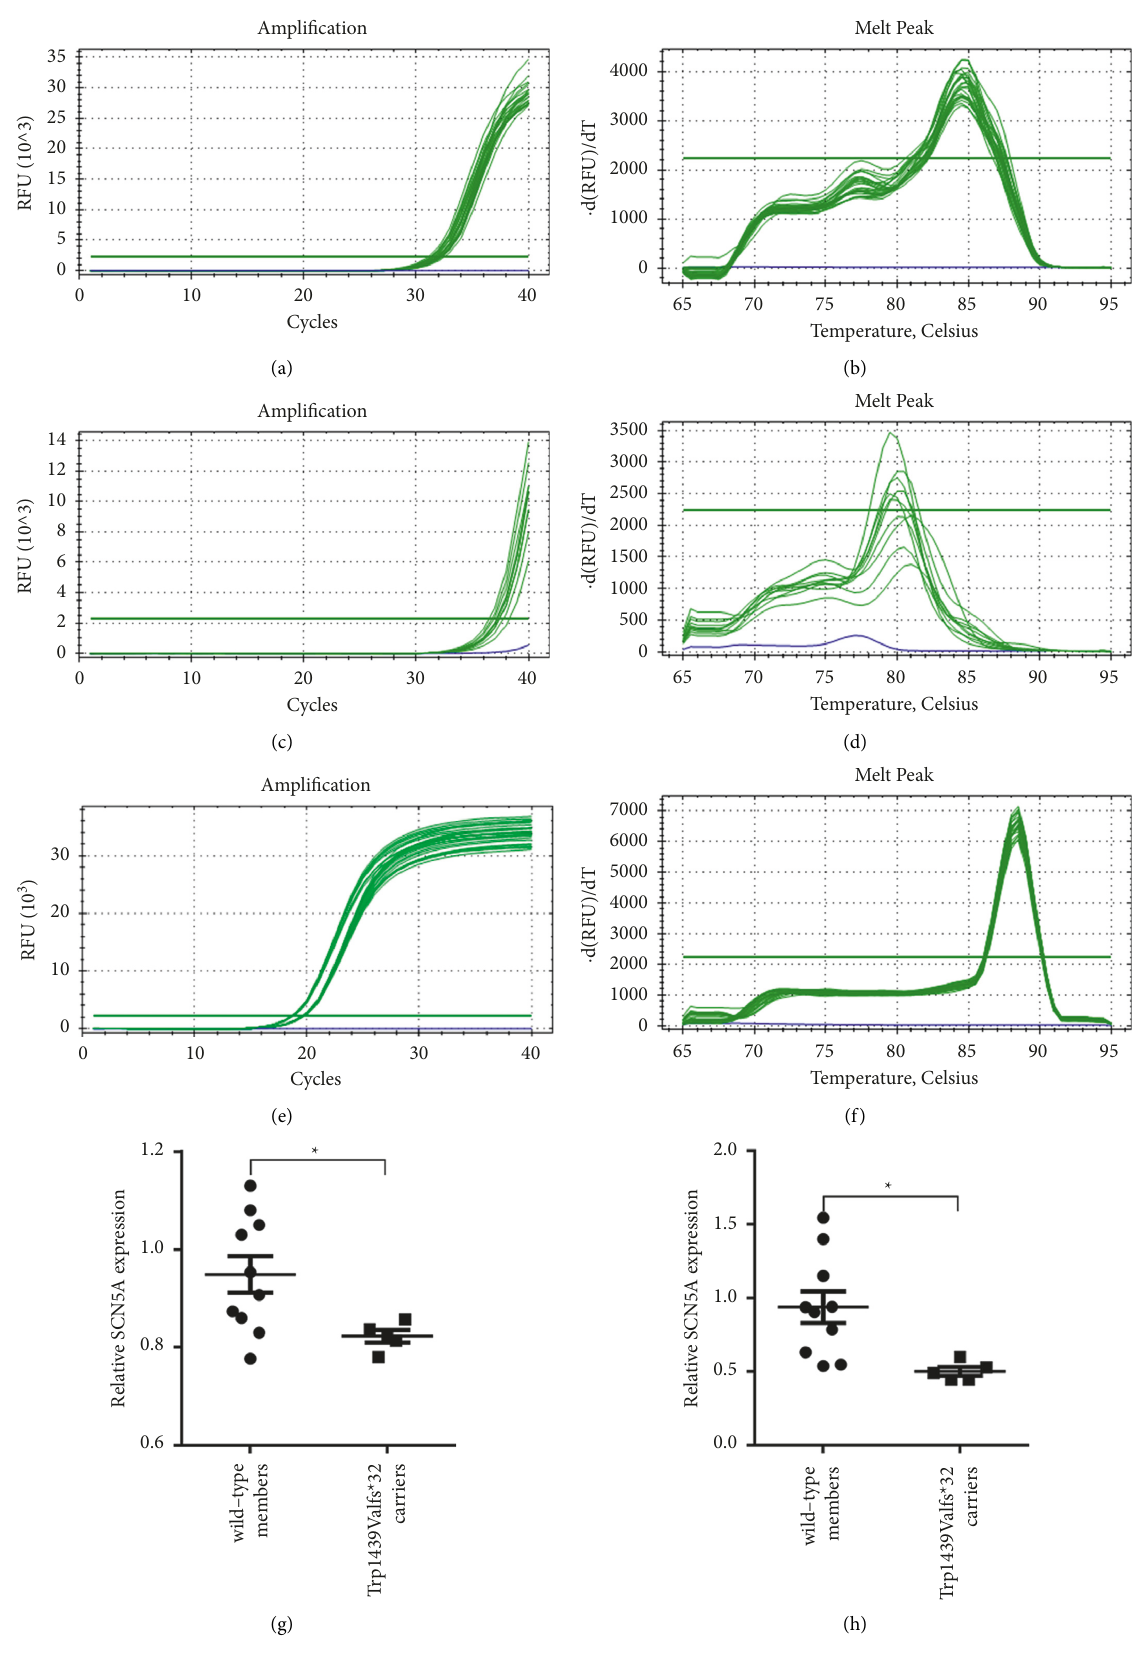
Figure 3: SCN5A mRNA expression analysis using real-time qPCR. (a ‒ f) The SCN5A amplification and dissolution curves. (g, h) The SCN5A expression differences of WT members ( n � 5) and p.Trp1439ValfsTer32 carriers ( n �